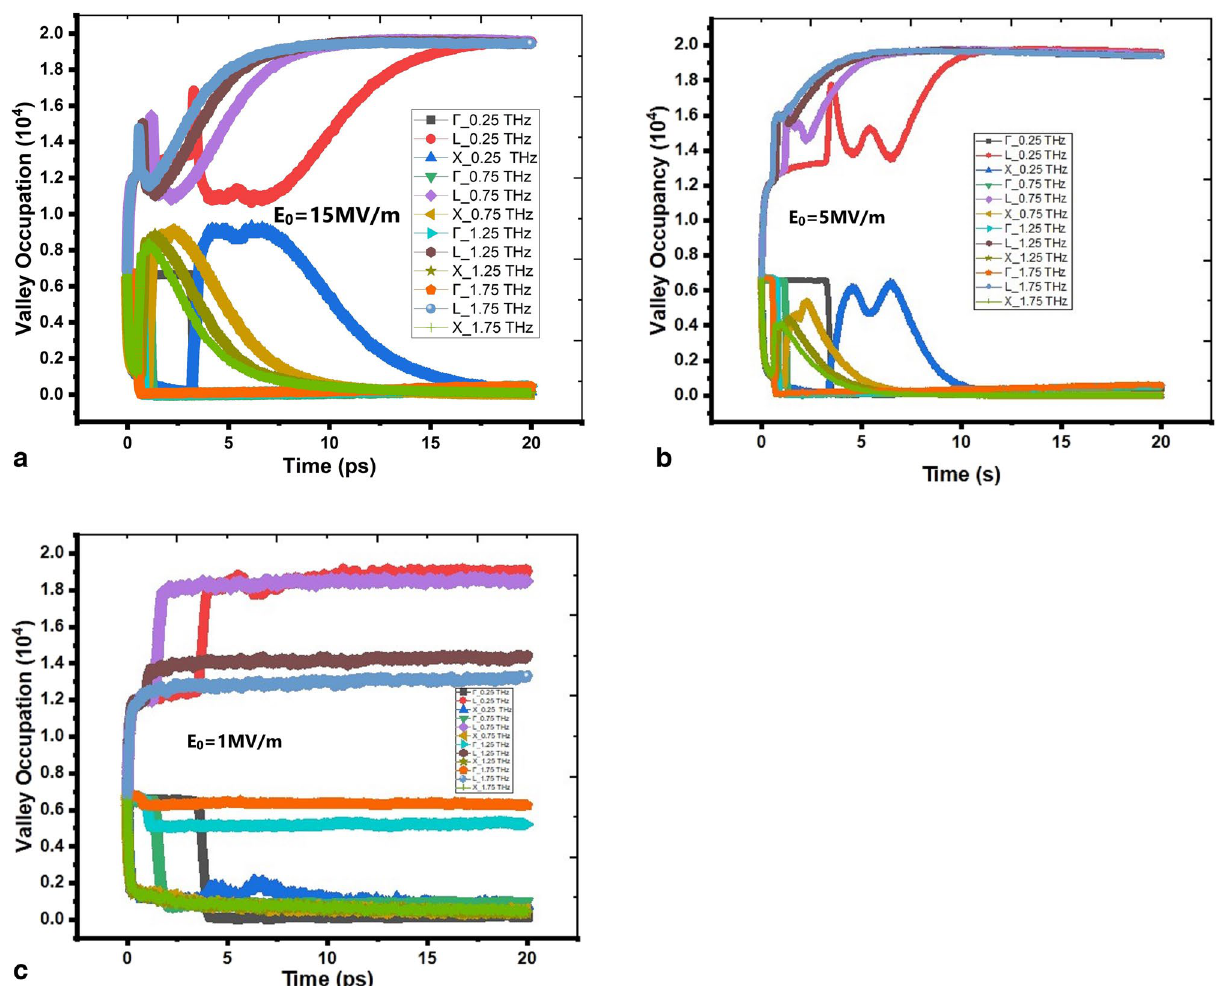
Figure 5. ( a – c ). Variation in Valley Population at various THz Frequencies at peak field intensity 15, 5 and 1 MV/m with respect Time The variation of time-domain-carrier-occupancy densities at Γ-valley (Red), L-valley (Blue), X-valley (Green) with the impact of single cycle THz pulse (black) at f = 0.25 THz and E 0 = 15 MV/m are shown in Fig. 4 . The intrinsic noise due to the carrier transitions is suppressed by delaying arrival of each single cycle pulse with time delay of 3/4 T. Here, T is the time period of the pulse. Under steady state conditions, Boltzmann thermal popula- tion is observed in the L- and Γ-valleys. The interaction of single cycle THz pulse prompts the carrier intervalley transitions from L-valley and Γ-valley to X-valley, which is highest energy level in Ge. The variation in L- and X-valley population densities is attributed to the free carrier absorption mechanism. The interaction time of carriers with THz pulse is obviously dependent upon the pulse width. The free-carrier absorption mechanism can be explained with the help of valley carrier population densities at any instant during the simulation. Most of the X-valley electrons de-excite to lowest energy level (L-valley) as the single cycle pulse passed over through the sample and is clearly reflected from Fig. 4. The Fig. 5a–c elaborate more details about the microscopic valley transitions behavior of the electrons with various single cycle THz pulses. The three valleys i.e. L-, Γ- and X-valley carrier population density at f = 0.25, 0.75, 1.25, 1.75 THz in Fig. 5a–c at peak field strengths E 0 = 1, 5, 15 MV/m respectively reflect that the free carrier absorption mechanism is strongly dependent on the pulse width of each single cycle pulse. The carrier population of the three valleys changes in a different way with change in peak field intensities. The transfer of carriers from lower energy level (L-valley) to higher energy level (X-valley) increases with increasing field strength at a given frequency. Similar phenomena is observed in the transition behavior of carriers with increasing THz frequency at a given peak field strength. Such behaviors are expected too. The acoustic and Coulomb scattering rates at L-, Γ- and X-valley are depicted in Fig. 6a. The Γ-valley acoustic and Coulomb scattering rates are very low as compared to L- and X-valley rates which indicate that the popula- tion in Γ-valley is very low. In the Ge semiconductor, Γ-valley lies at middle of L- and X-valleys. Under steady state conditions most of the free carriers remain at L-valley, the carrier interaction with single cycle THz pulses lead to excitation to X-valley due to free carrier absorption mechanism. The nature of acoustic and Coulomb scattering rates are opposite to each other at each valley and can be seen by the curves in Fig. 6a. The carriers